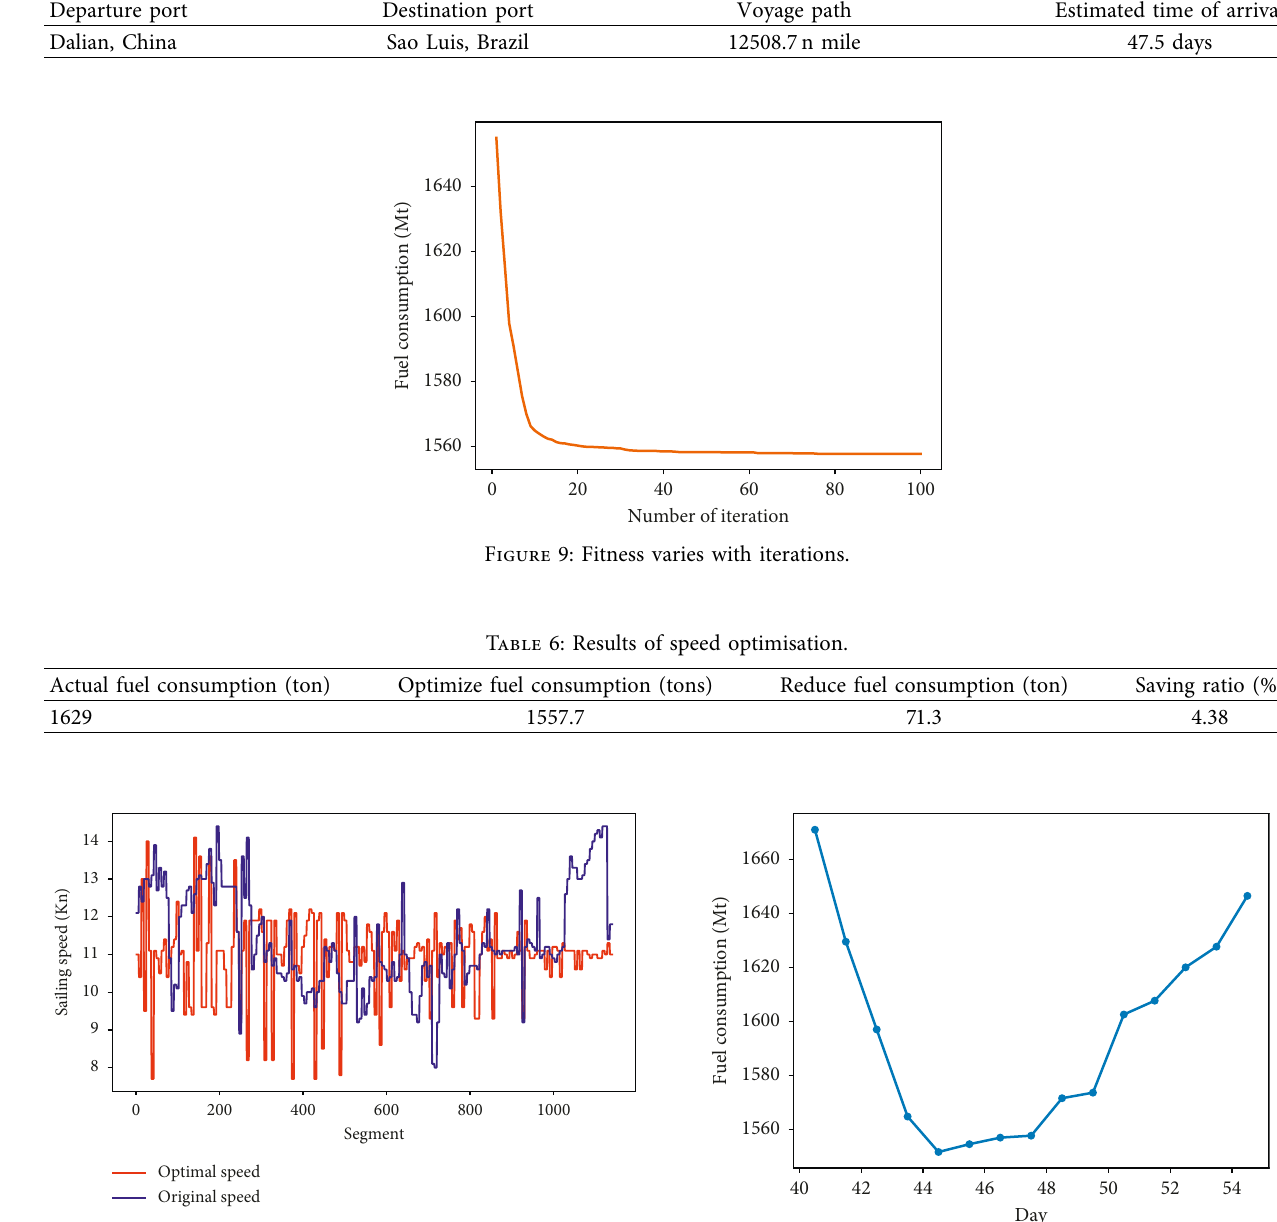
Figure 10: Optimal ship speed and original speed.